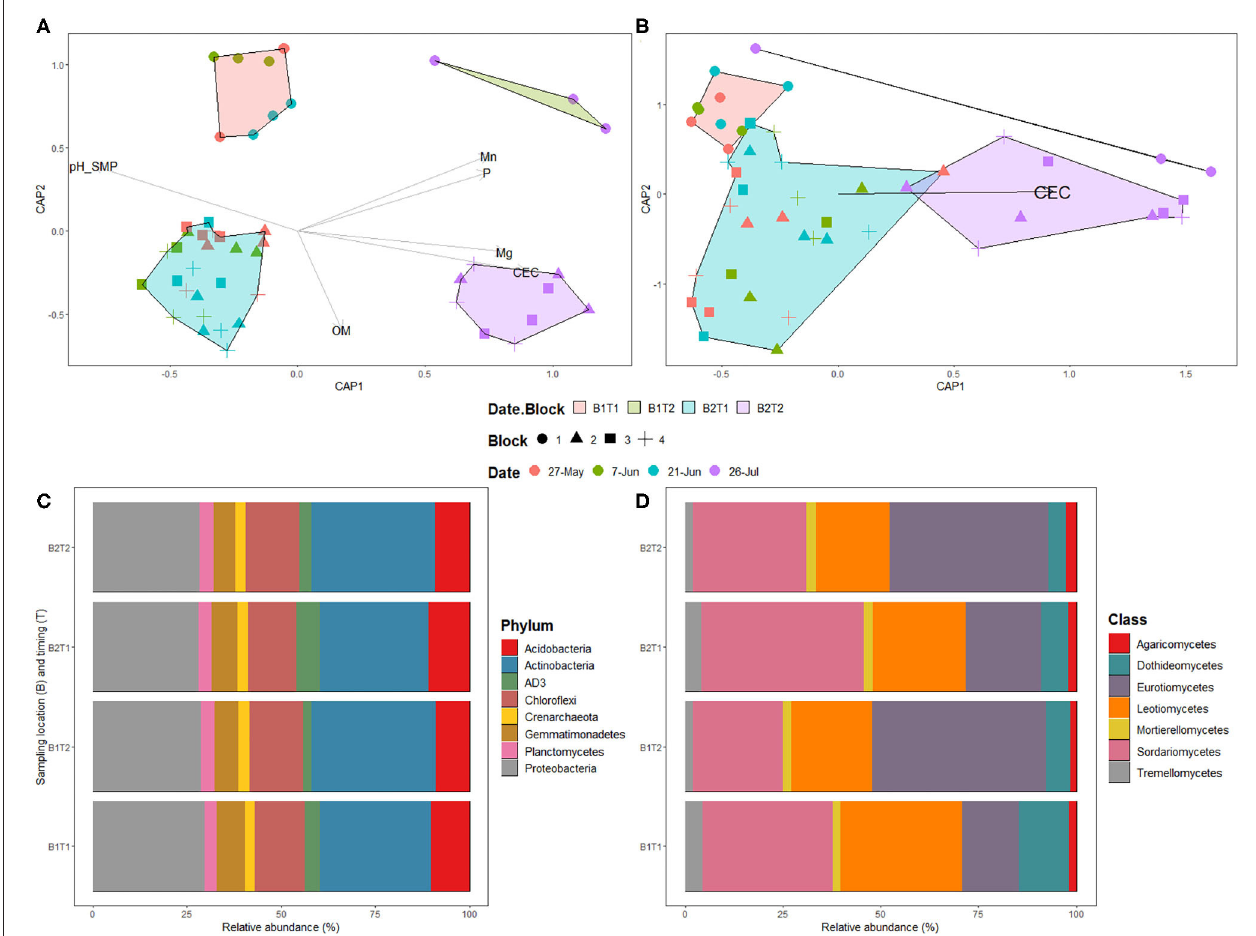
FIGURE 3 | Distance-based redundancy analysis (Db-rda) of prokaryotic (A) and fungal (B) communities in bulk soil samples. Db-rda were based on Bray-Curtis distance at the ASV level; Relative abundance of prokaryotic phyla (C) and fungal classes (D) in bulk soil samples. The Date.Block categories is as follow: B1T1: Block 1 on May 27th, June 7th, and 21st; B1T2: Block 1 on July 26th; B2T1: Blocks 2, 3, and 4 on May 27th, June 7th and 21st; B2T2: Blocks 2, 3, and 4 on July 26th.